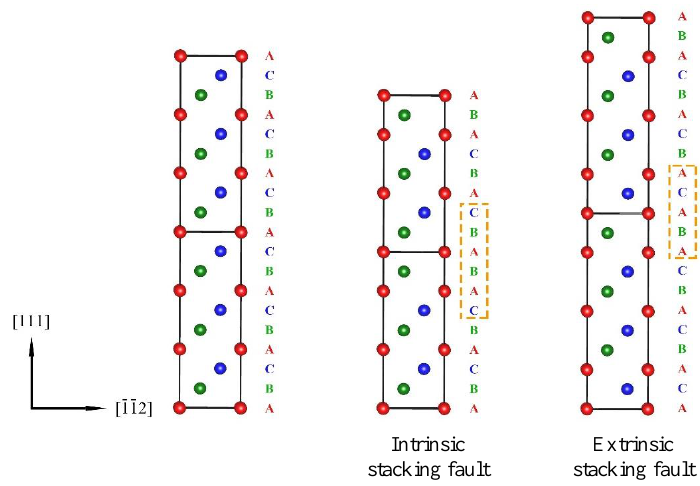
Figure 3. Slab supercell model for SFE calculations.